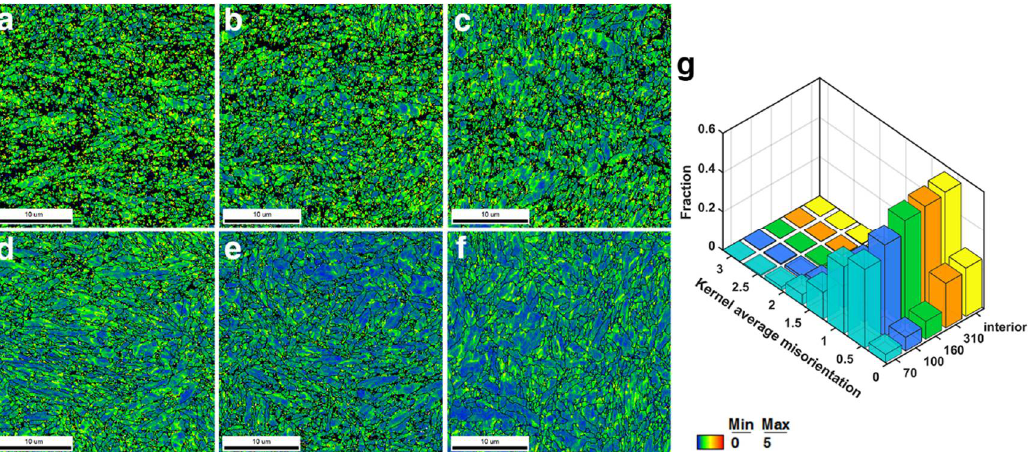
Figure 4. Kernel average misorientation (KAM) map of the rolled bolt at different distances from the surface of the thread: ( a ) 70 μm ( b ) 100 μm ( c ) 160 μm ( d ) 250 μm ( e ) 310 μm ( f ) interior region. ( g ) Frequency distribution of the KAM value in ( a – c , f ).